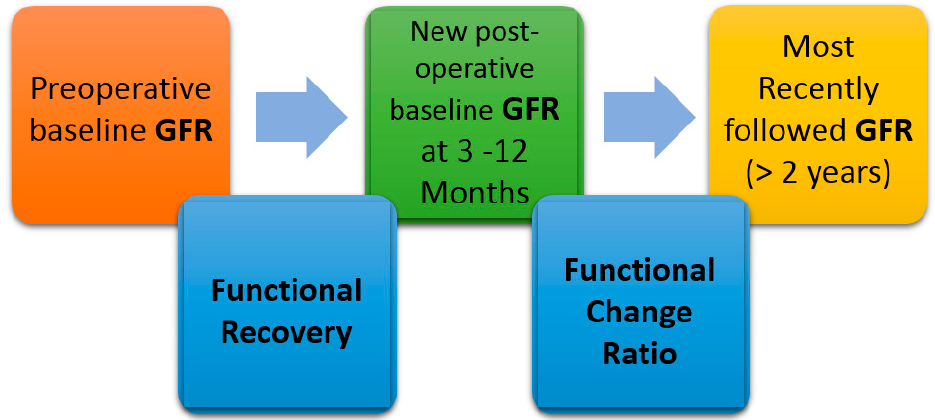
Figure 1. Study outcomes and time points of measurement. Functional recovery was measured as the ratio of glomerular filtration rate (GFR) at 3–12 months to preoperative baseline GFR. Functional change ratio was calculated as the ratio of most recent GFR to a new postoperative baseline GFR at 3–12 months. Preoperative baseline GFR was used as a baseline to calculate the outcome of functional recovery and a new post-operative baseline GFR at 3–12 months was used as a baseline to calculate the outcome of functional change ratio.